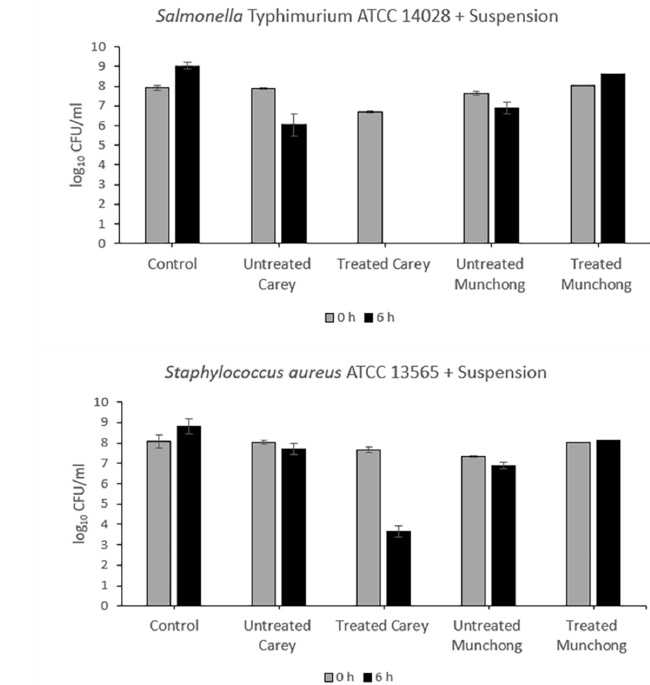
Figure 2. Antibacterial activity of untreated and treated clay suspensions of Carey and Munchong soils following 6 h exposure to clay leachates (500 mg/mL), with sterile deionized water as control: ( a ) Viability of Salmonella Typhimurium ATCC 14028; ( b ) Viability of S. aureus ATCC 13565. Table 4. Cation-exchange capacity of untreated and treated clay samples.